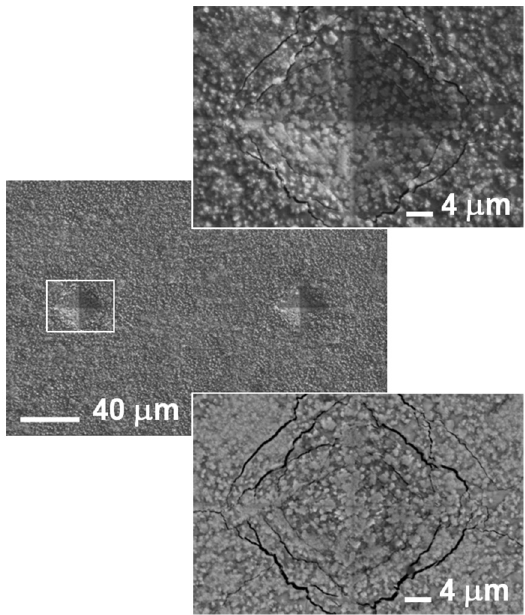
Figure 8. The cumulative mass loss (CML) curve as a function of the cavitation erosion time for non-nitrided and nitrided niobium surfaces (Fulfilled-solid icons are referred to the best results; non-fulfilled icons are referred to the worst one; and dashed lines indicate the variation field of the